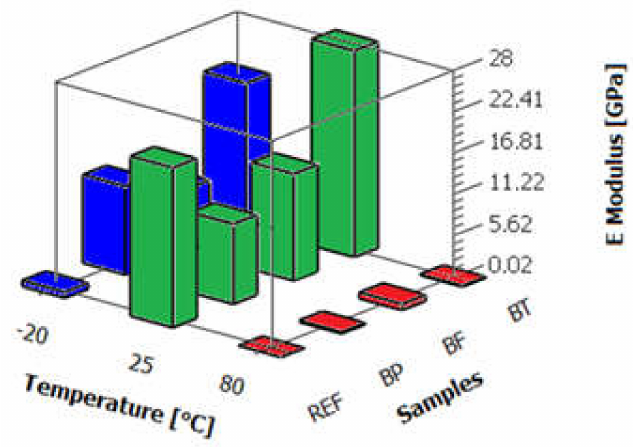
Figure 13. Young’s E modulus vs. temperature for sample EP (REF) and composites EP reinforced with basalt powder (BP), basalt fibre (BF) and basalt textile (BT) (Table